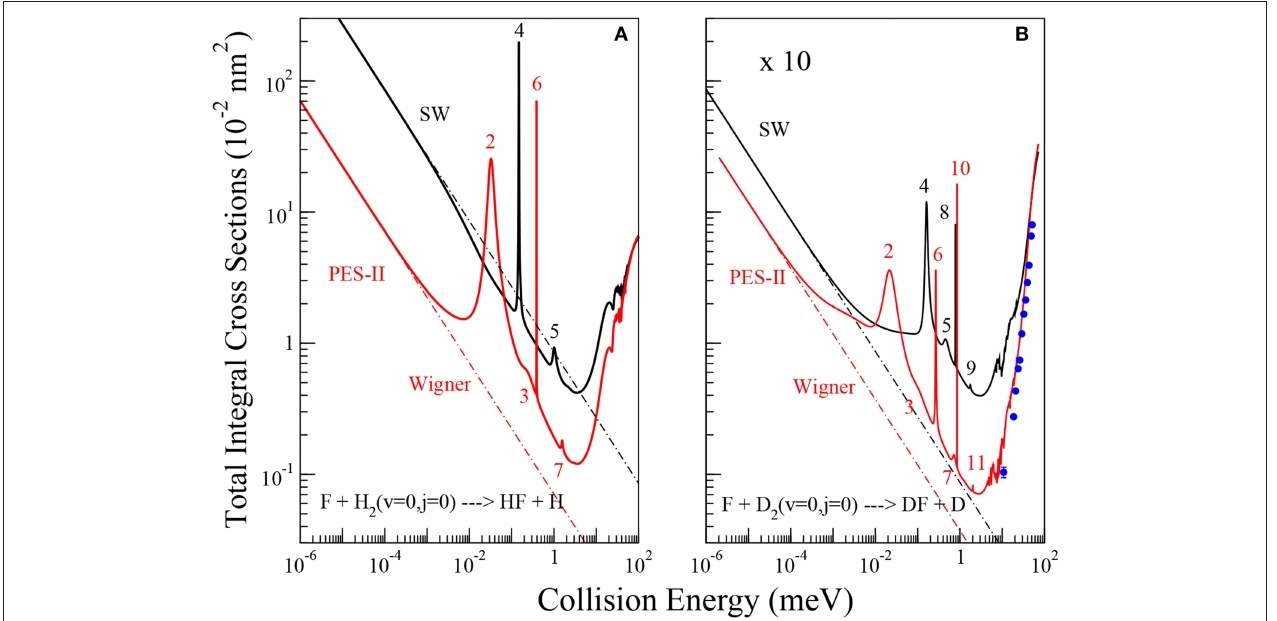
FIGURE 1 | Energy dependence of the ics for the reactions of the F atom with H 2 , panel (A) , and D 2 , panel (B) , molecules in their ground roto-vibrational state. The solid black and red lines are the results using SW PES and PES-II, respectively. The dot-dashed lines show the fittings of numerically exact ics to the Wigner threshold law (Equation 8). A pattern of J -selected resonance peaks appears in the cold energy region. The value of the total angular momentum quantum number where the peaks show up in the reaction probabilities is indicated. Blue dots with error bars are the experimental values of reference (Che et al., 2007).